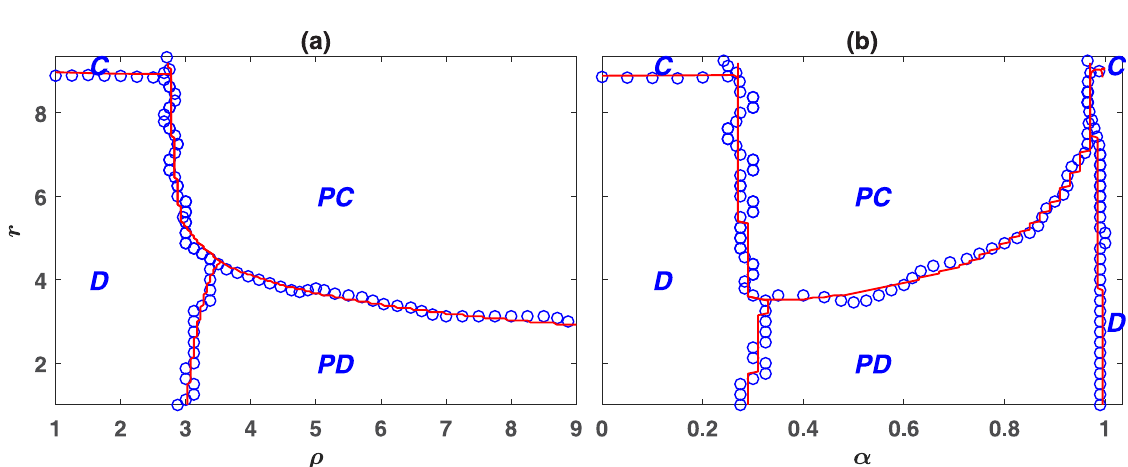
Fig 1. The phase diagram of the wasteful punishment model in a well-mixed population. Blue circles denote the results of a simulation in a population of size N = 10000, and the red lines denote the results of the replicator dynamics. Depending on the parameters of the model, the model shows four different phases. C , D , PC , and PD denote different phases in which, respectively, cooperators, defectors, punishing cooperators, and punishing defectors dominate. Here, g = 9, ν = 0.001, c = c 0 = 1. In (a) α = 0.5 and in (b) ρ = 5.